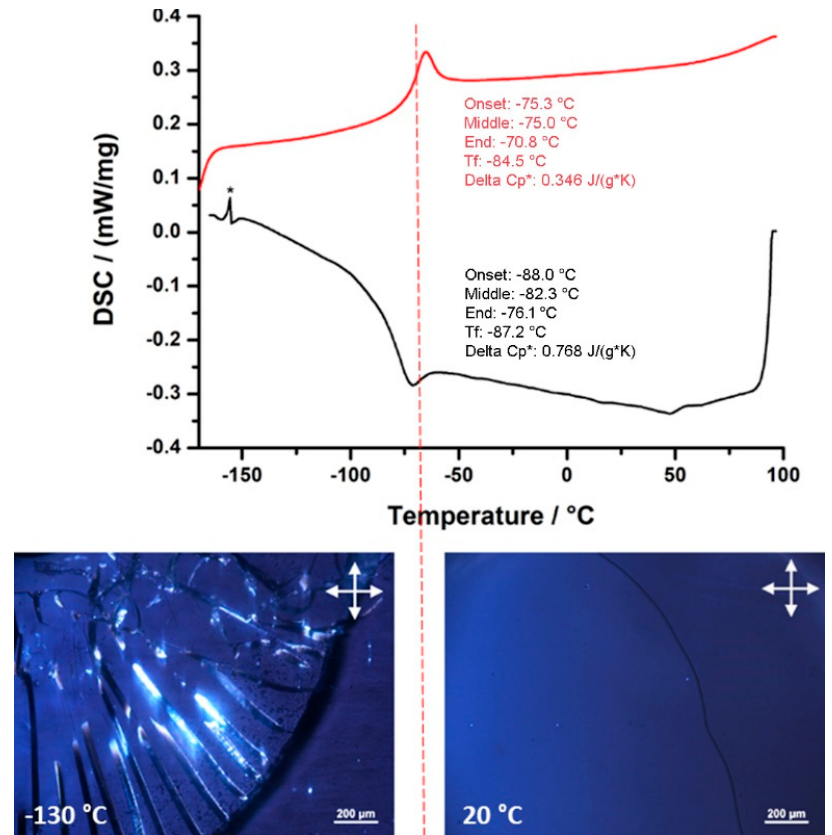
Figure 4. DSC traces in the heating (red) and the cooling (black) modes for compound 2 . Images taken at − 130 °C and +20 °C by Polarized Optical Microscopy (* = artefact). Table 1. Summary of the rheological properties of all the compounds investigated.